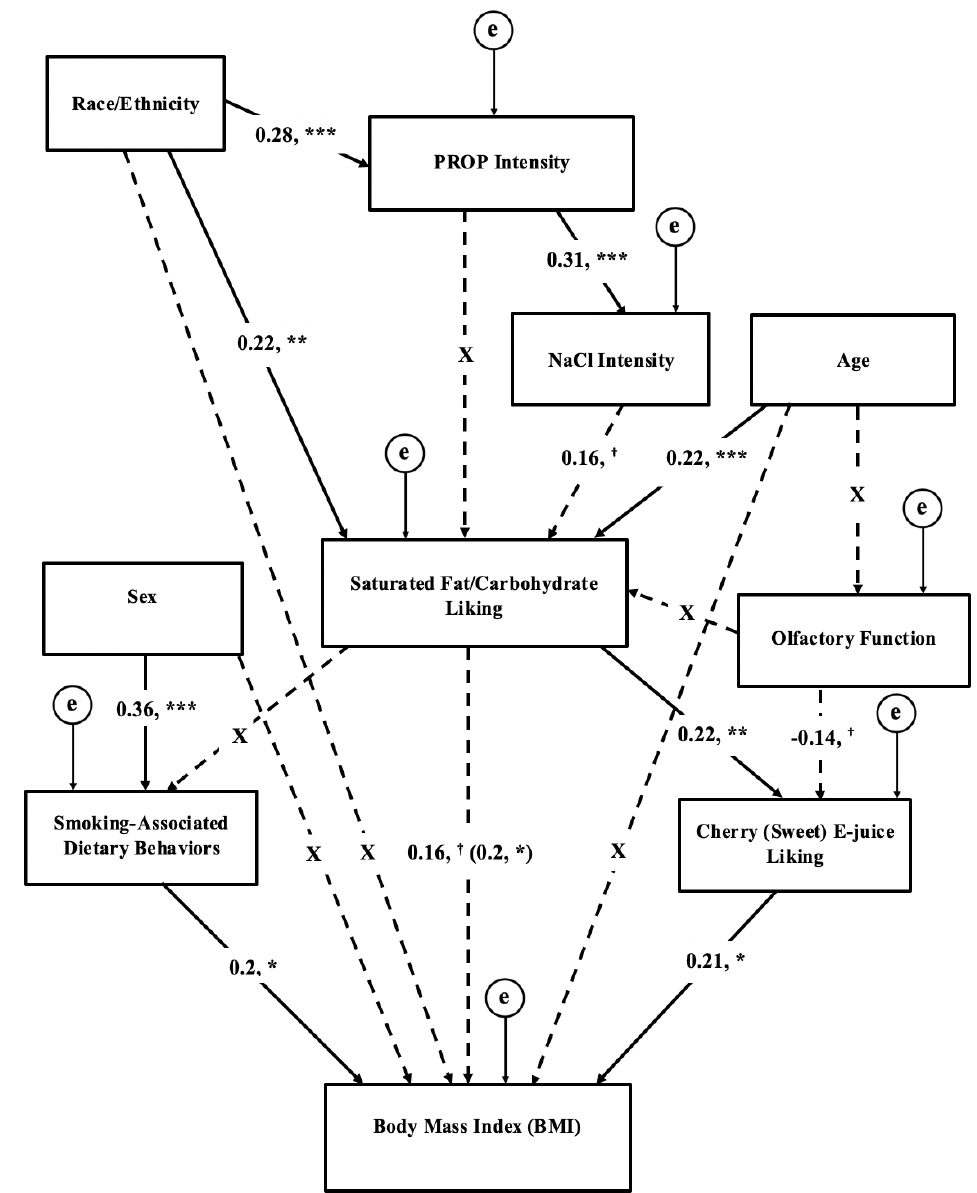
Figure 1. Conceptual hypothesis-based model of associations between chemosensation, liking, smoking-associated dietary behaviors, and BMI in chronic adult smokers. The numerical values labeled on the arrow lines represent standardized beta coefficients. Errors (represented by the encircled letter “e“) are required computationally, but are not of theoretical interest. The coefficient in parenthesis represents the associations before cherry e-juice liking was added to the model. indicating that cherry e-juice mediated the dietary preference-BMI relationship (indirect effect coefficient = 0.05, p < 0.05). Dashed lines with “X” coefficients indicate non-significant associations. The model was adequately fit (CFI = 1.00, TLI = 1.03, Chi-square = 25.6, df = 27, p = 0.54, RMSEA = 0.00, 90% C.I. 0.000–0.063). *** indicates that p ≤ 0.005; ** p ≤ 0.01; * p ≤ 0.05; † p ≤ 0.1. (PROP= 6-n-propylthiouracil).